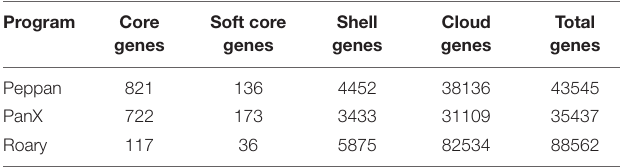
TABLE 2 | Number of genes per pangenome